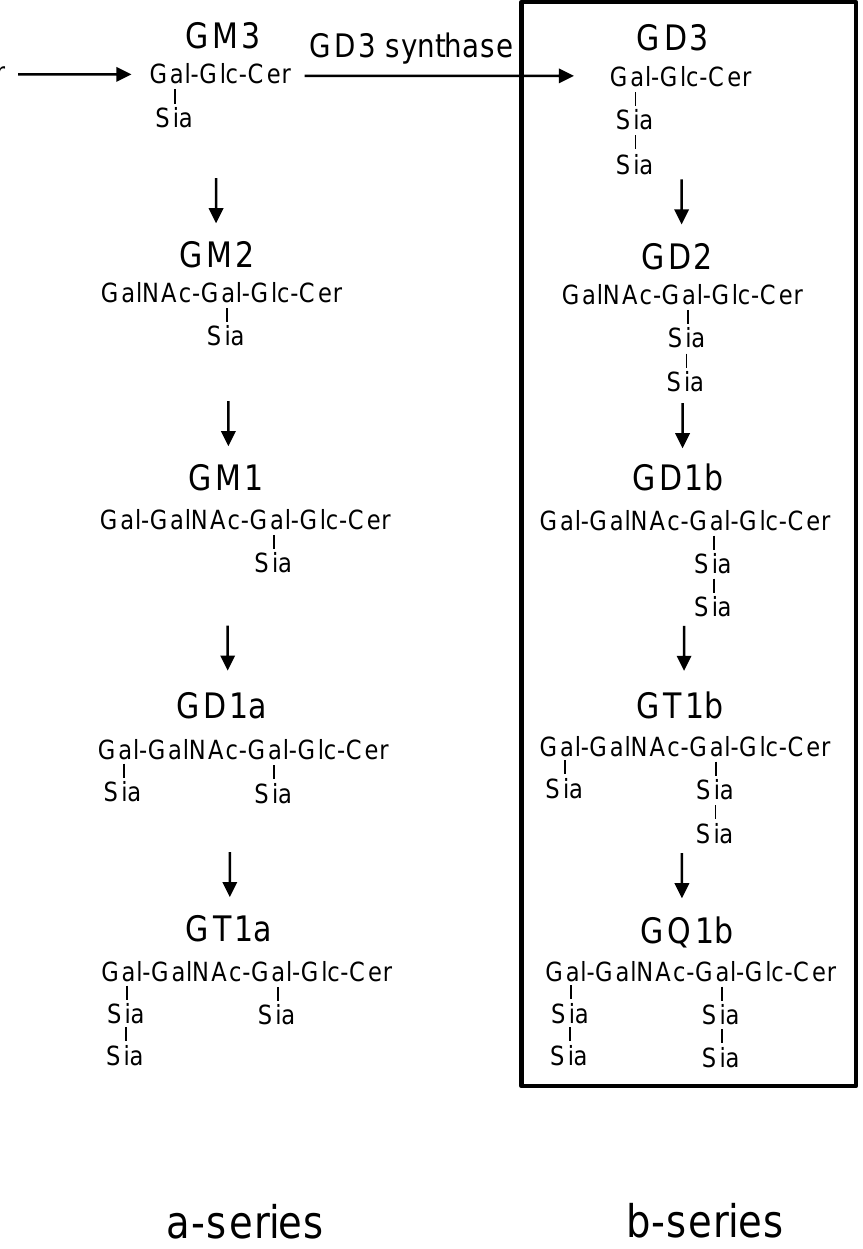
Figure 1. Synthetic pathway of gangliosides and the e ff ects of targeted disruption of GD3 synthase. All b-series gangliosides (GD3, GD2, GD1b, GT1b, and GQ1b) in the box were deleted in GD3 synthase-knockout (GD3S KO)